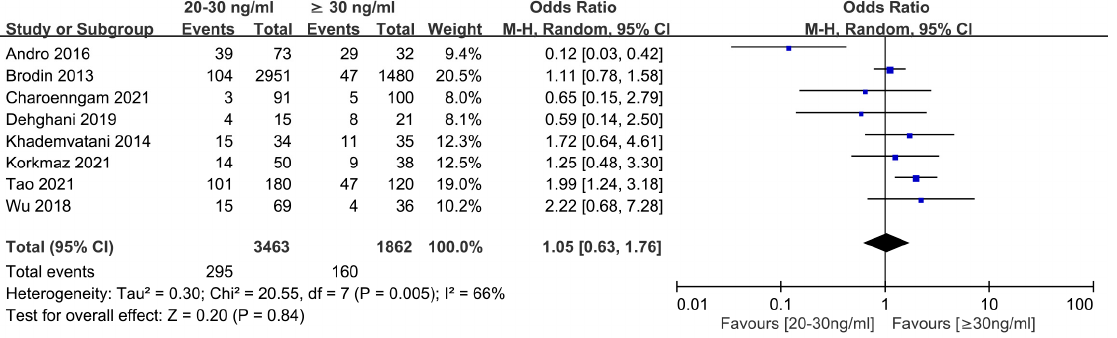
Figure 6. Subgroup analysis comparing the risk of venous thromboembolism between participants with vitamin D insufficiency and those with a normal vitamin D status. CI, confidence interval; M-H, Mantel-Haenszel. The measure of effect (e.g., an odds ratio) for each of these studies is represented by a square incorporating confidence intervals represented by horizontal lines. The vertical line is “Line of no effect”. The area of each square is proportional to the study’s weight in the meta-analysis. This meta-analysed measure of effect is plotted as a diamond, the lateral points of which indicate confidence intervals for this estimate [18,19,28–30,35,38,39].